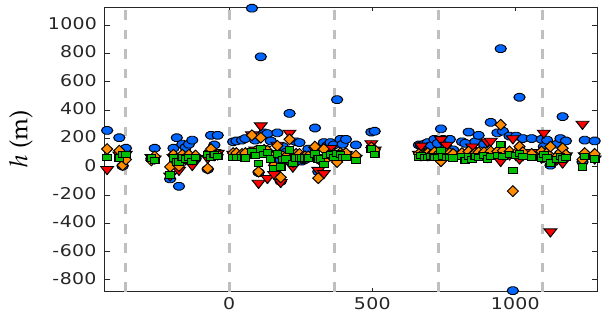
Figure 4. Measured height given the number of days separating the acquisitions. • Eiffel Tower, (cid:72) Cristal Tower, (cid:7) Keller Tower, (cid:4) Mirabeau Tower. The vertical dashed lines represent the years from the master image acquired the 24 January